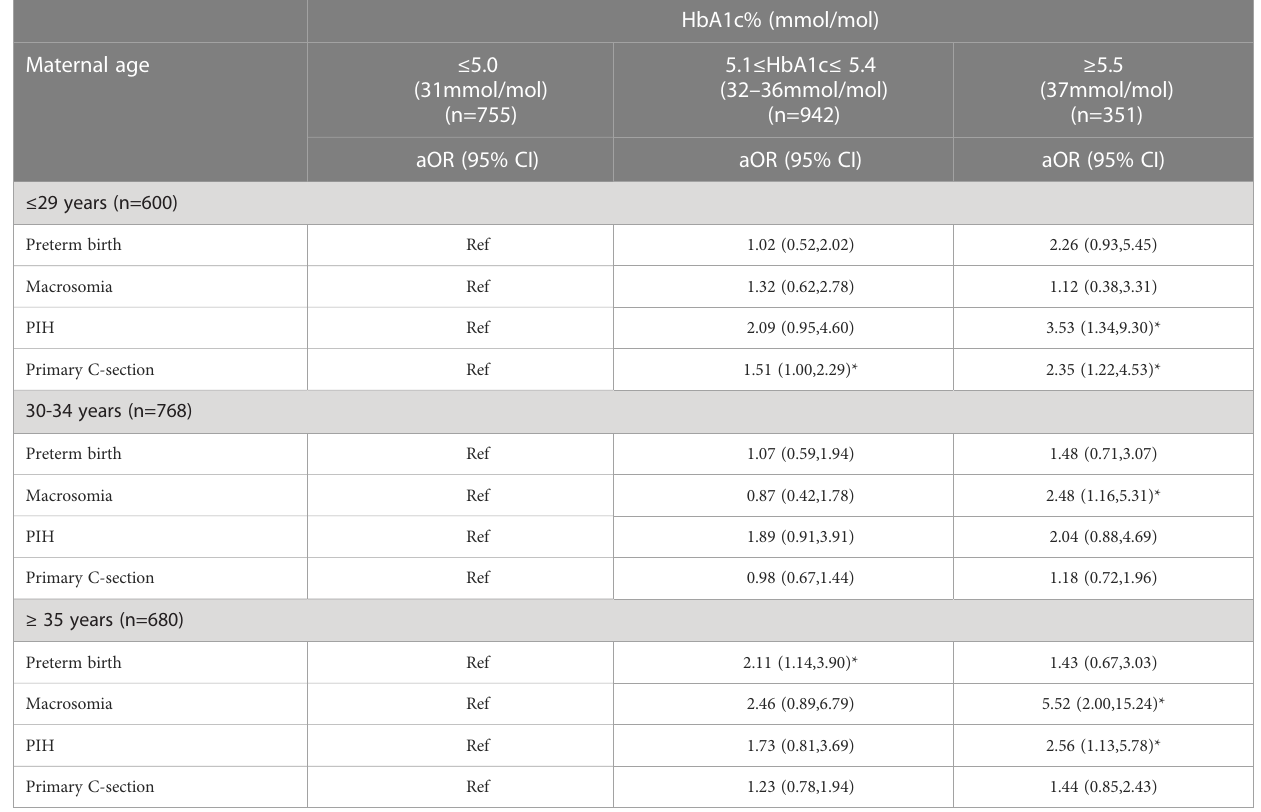
TABLE 3 Association between HbA1c and adverse outcomes in different maternal age